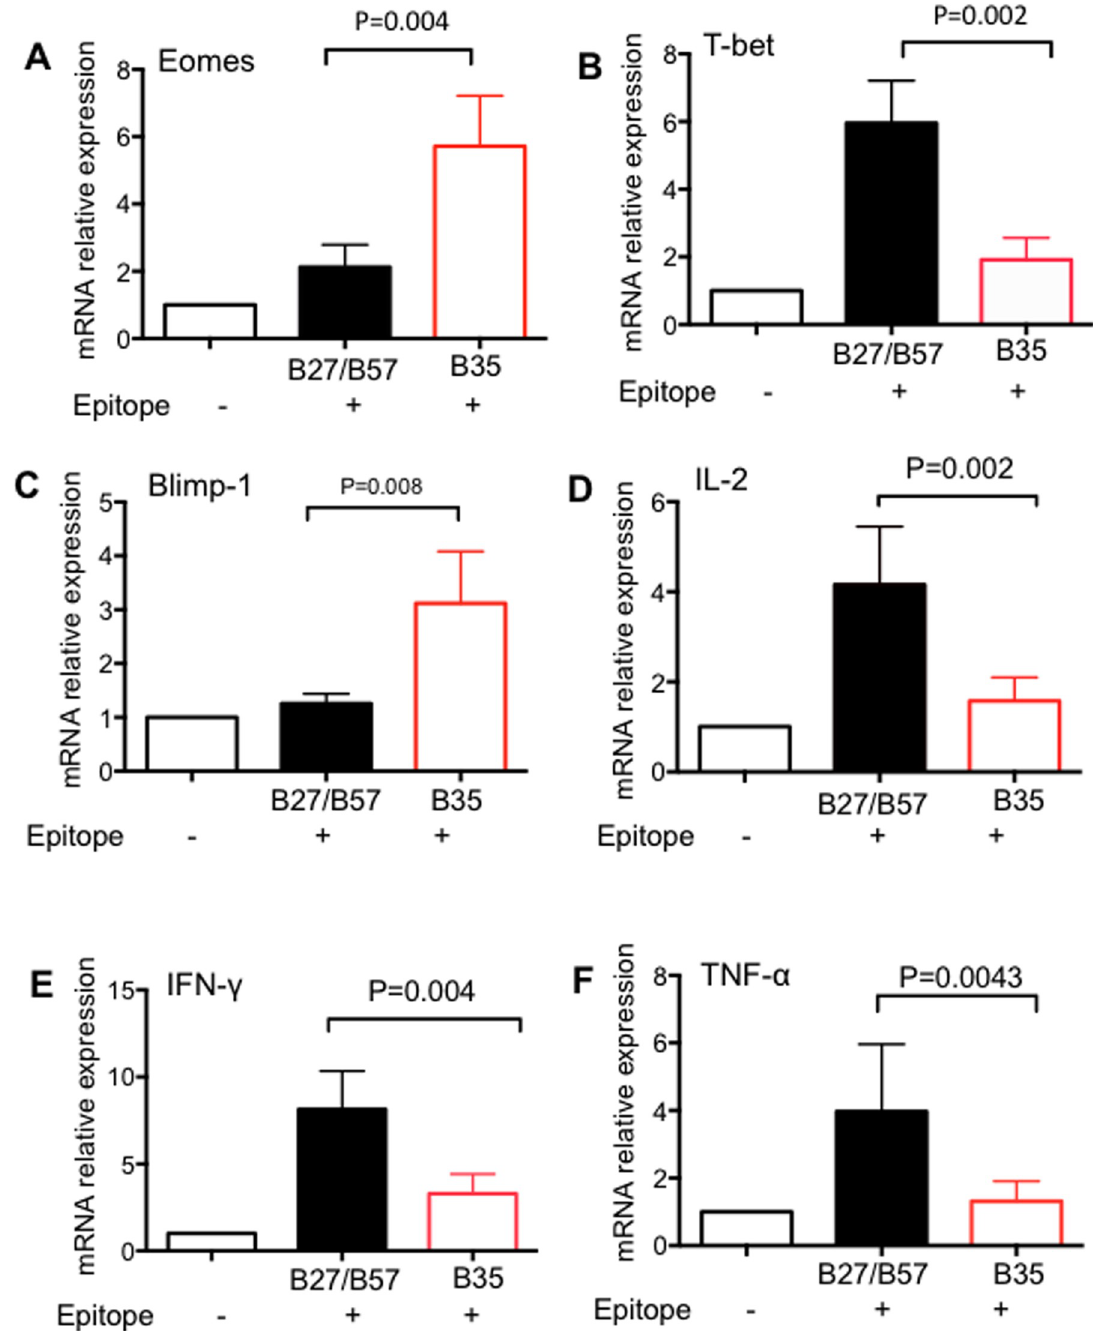
Fig 7. HLA-B � 35Px restricted CTLs exhibit an exhausted phenotype at the gene level. (A ) Relative mRNA expression of Eomes, ( B) T-bet, ( C) blimp-1, ( D) IL-2, E) IFN- γ and F ) TNF- α in CD8 + T cells restricted by HLA-B � 35Px versus those restricted by HLA-B � 27/ B57 as quantified by qPCR. Data are from a minimum of five antigen-specific CD8 + T cells restricted by each HLA-type and isolated by sorting for RNA isolation and qPCR. Bar, mean ± one standard error. of CTLs restricted by HLA-B � 27/B � 57 alleles[3,12,13,35]. However, this is not in line with a report showing the lack of difference in cytokine production and degranulation between HLA-B � 57 and HLA-B � 35 carriers[33]. One possible explanation for the discrepancy in